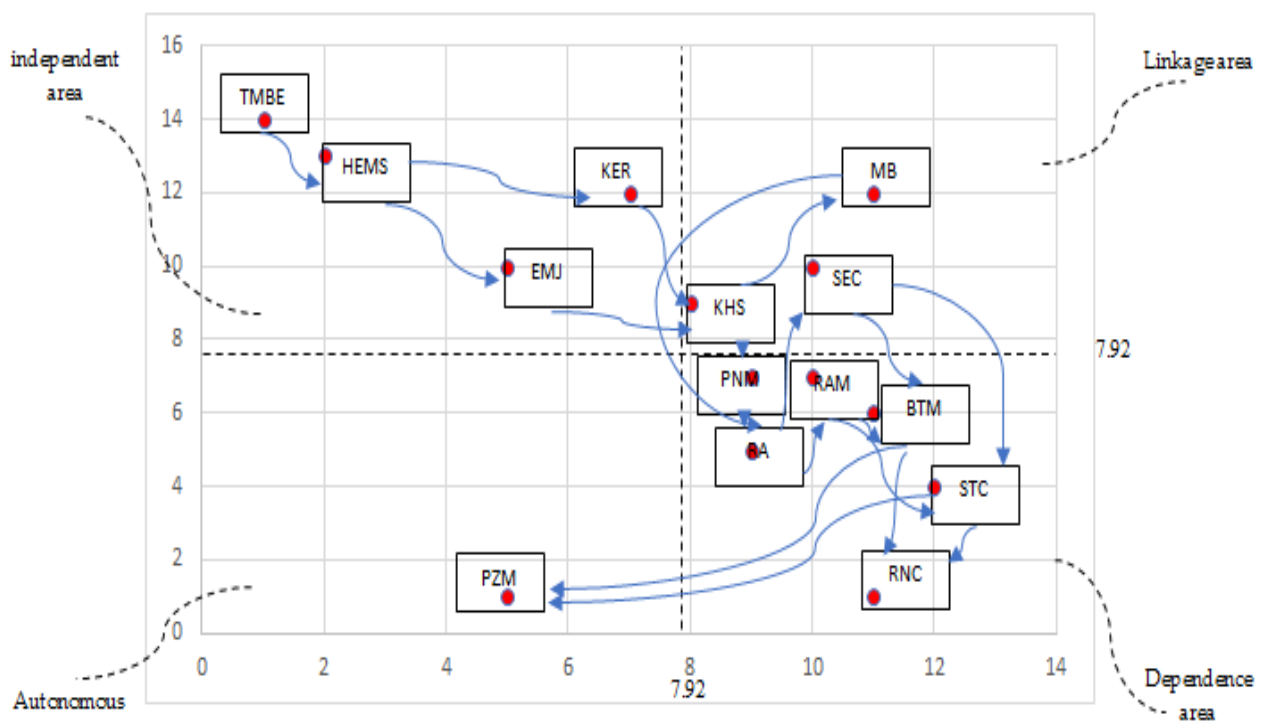
Figure 4. MICMAC analysis (Ref: Authors).